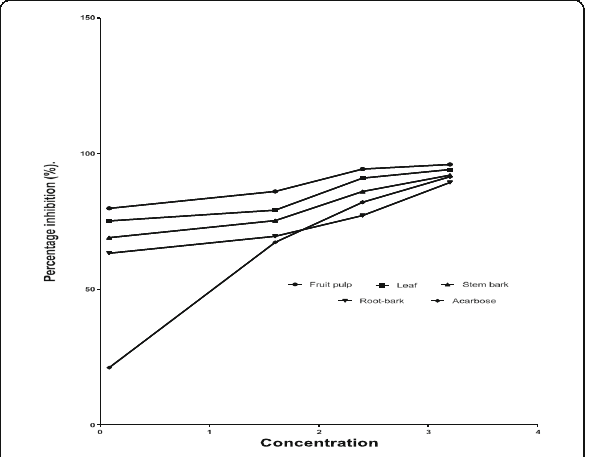
Fig. 10 Percentage inhibition of α -glucosidase by methanolic extract of Annona muricata fruit-pulp, leaf, stem-bark, root-bark and acarbose (reference standard)